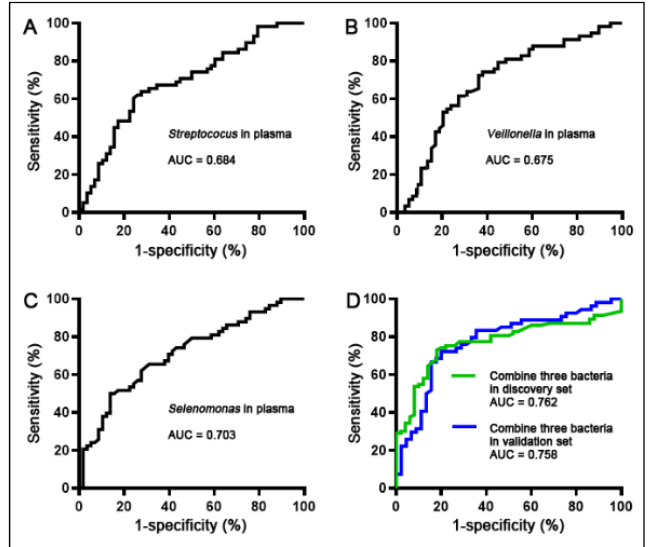
Figure 5. The panel of three plasma bacterial biomarkers for NSCLC detection. ( A – C ). The perfo- manace of Streptococus , Veillonella , and Selenomonas was detemined by uisng AUC values. ( D ). The three plasma bacterial biomarkers used in combination in the discovery set (Green line) and the validation set (Blue line) yields 0.76 AUC, respectively, which is better than individual ones ( p < 0.05). However, there is no statistical difference of AUC values of the biomarker panel in discovery set vs. validation set ( p = 0.69).